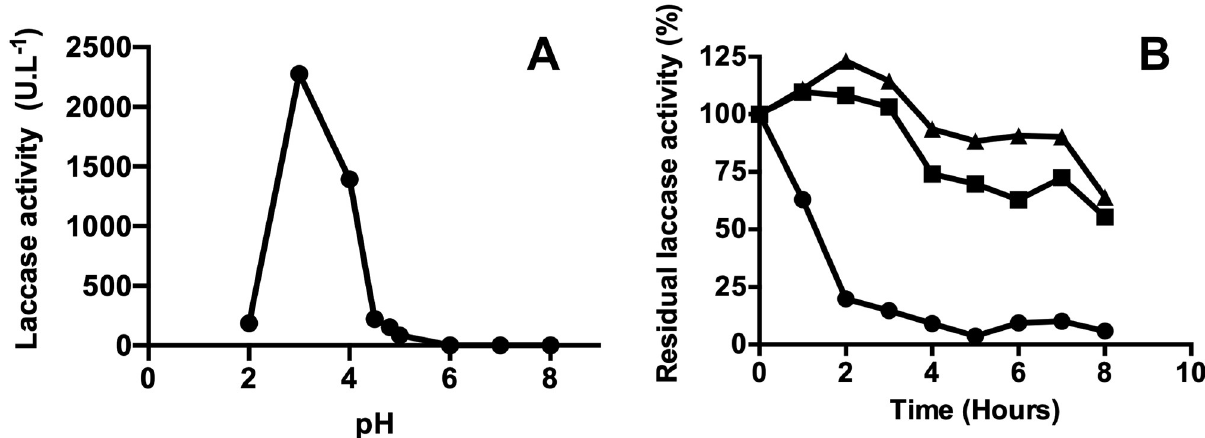
Fig 3. pH tolerance of a D . pusillus LMB4 extract exhibiting laccase activity. A) Laccase activity from a crude D . pusillus LMB4 enzymatic extract at different pH values. B) pH stability assay performed with the crude enzymatic extract from D . pusillus LMB4. Laccase activity was evaluated at 40˚C under different pH conditions: pH 3 (circles), pH 4 (squares), and pH 5 (triangles). Average values and standard deviation were obtained from three replicates of each point.